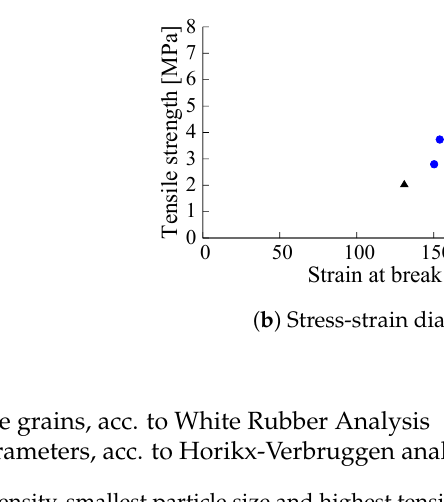
Figure 8. Samples with optimal decrease in cross-link density, smallest particle size and highest tensile strength in Horikx- Verbruggen cq. stress-strain